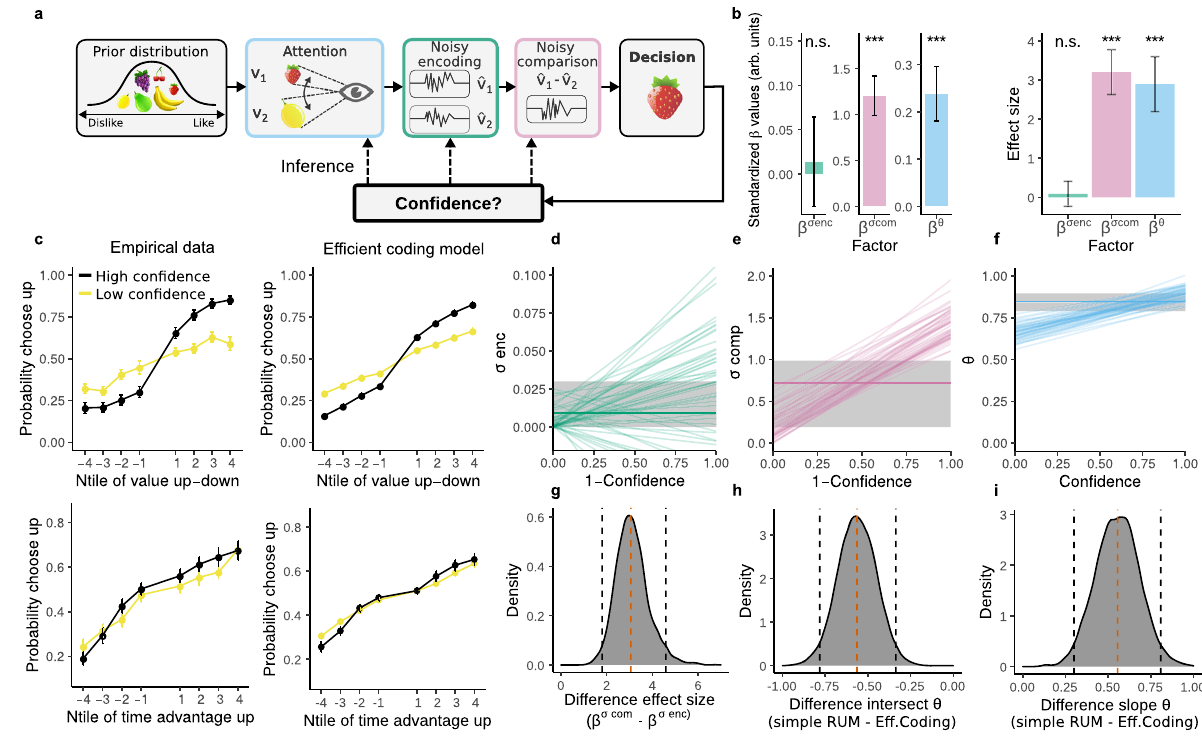
Fig. 5 The ef fi cient coding model. a The decision process with three distinct process stages, color-coded to match the graphs. The prior matches the distribution of subjective values v of supermarket products. When choosing between two items, subjects look repeatedly at them, spending unequal time on the two options. The subjective values are internally encoded, the corresponding likelihood function p ð ^ v j v Þ is constrained by the prior p ( v ) via ef fi cient coding. Lastly, noise that occurs after the decoding is taken into account. b Standardized posterior estimates of the relationship between con fi dence and variance in the encoding process ( β σ enc ), the variance in the comparison process ( β σ comp ), and attentional factors ( β θ ). ( β σ enc ) is not signi fi cantly different from 0 ( P = 0.39), both ( β σ comp ) and ( β θ ) are signi fi cantly bigger than zero with P < 0.001. The effect size of ( β σ enc ) is not signi fi cantly different from 0. Both the effect sizes of ( β σ comp ) and ( β θ ) are signi fi cantly bigger than zero with P < 0.001. Error bars indicate the mean posterior estimate of the standard deviation. P -values are based on the highest density interval of the posterior estimates. c Left column: the empirical probabilities of choosing the upper item; up: as a function of value difference; down: as a function of the difference in dwell time. Right column: the same as left but for the predicted probabilities by the ef fi cient coding model. The trials are median split in high/low con fi dence. Value difference and dwell time difference are split into eight groups of equal size. Data are presented as mean values ± SEM. Source data are provided as a Source Data fi le. d Comparison of parameter estimates of two alternative ef fi cient coding models: a model with agent-speci fi c estimates of σ enc and a model that allows for trial-to-trial fl uctuations of σ enc . The median of the posterior estimate of σ enc of the agent-speci fi c model is indicated by the horizontal green line, the shaded grey area indicates the 95% con fi dence interval. The diagonal green lines represent 100 random samples of the posterior distribution of how σ enc changes with con fi dence in the model allowing for trial-to-trial fl uctuations. e , f Same as ( e ) but for σ comp and θ . g Comparison of the effect sizes of the posterior estimates of σ enc and σ comp . Vertical red dashed line indicates the median, black lines indicate the 95% con fi dence interval. h Comparison of the posterior estimates of the intercept of θ in the ef fi cient coding model and the RUM. i Comparison of the posterior estimates of the slope of θ in the ef fi cient coding model and the RUM. For the whole fi gure n = 33 independent